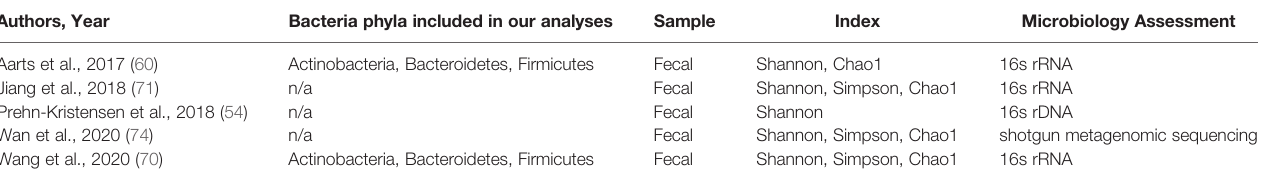
TABLE 4 | Characteristics of the Microbiota Assessment in the Included